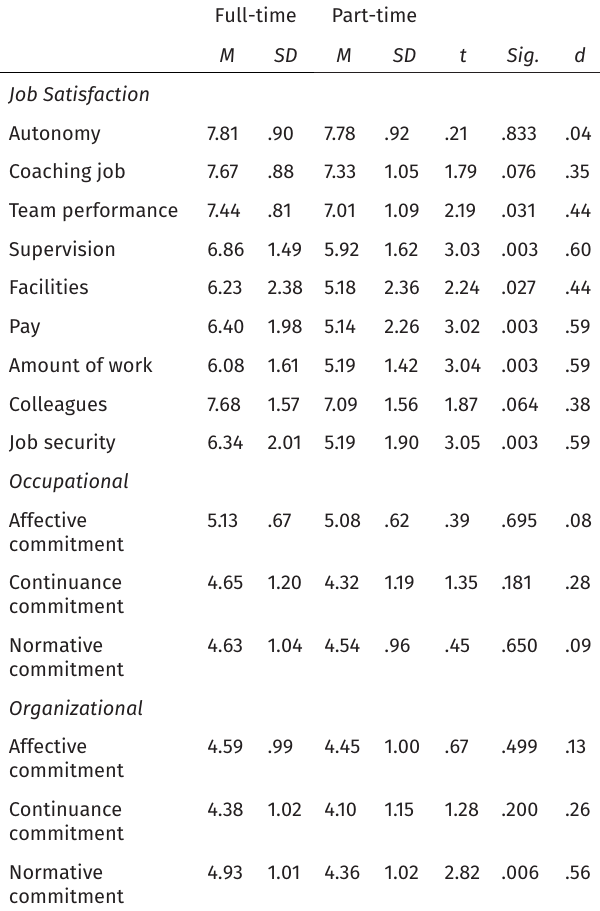
Table 1a. Mean differences in all variables between full time and part time